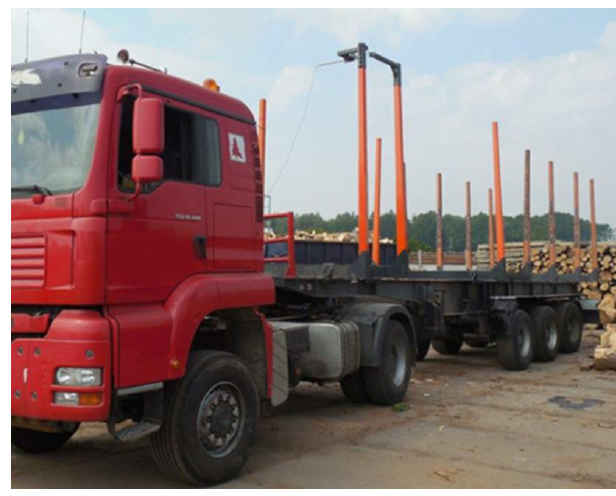
Figure 1. View of the truck stanchions with the displacement transducer before the timber was loaded.